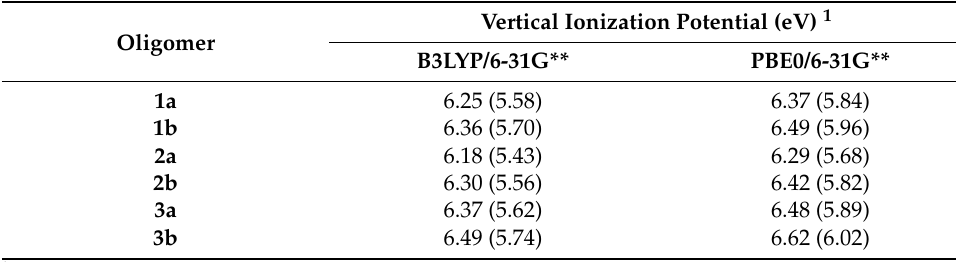
Table 3. DFT-calculated vertical ionization